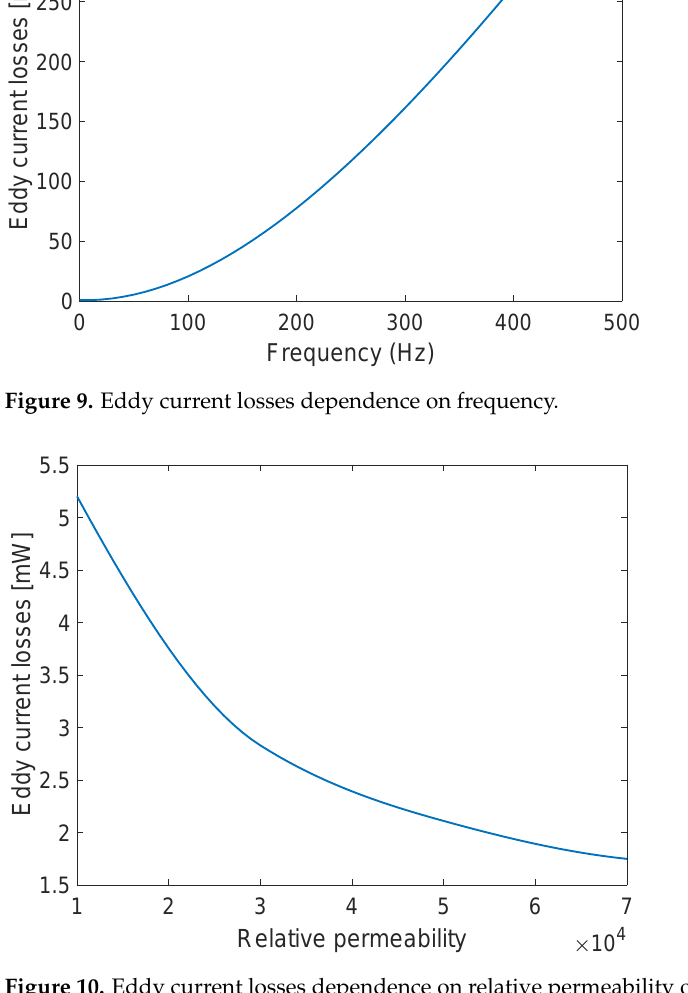
Figure 10. Eddy current losses dependence on relative permeability of the core magnetic